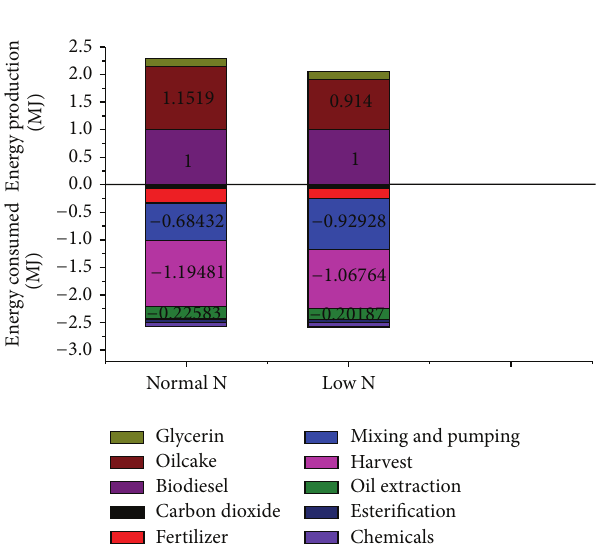
Figure 2: Phaeodactylum tricornutum . Energy losses and gains for the production of biodiesel from Phaeodactylum tricornutum grown in N-sufficient and N-limited mediums.